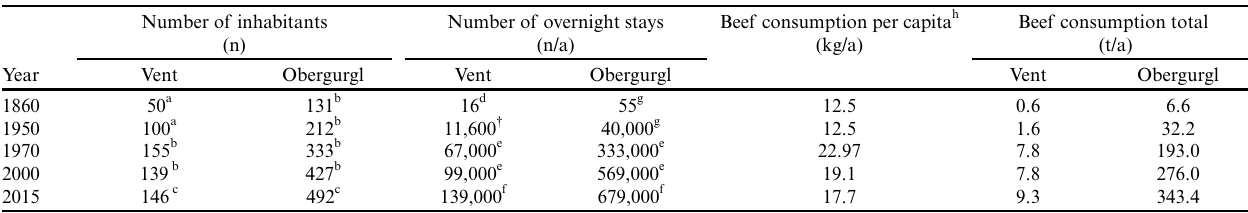
Table 5 . Beef demand in the villages Vent and Obergurgl for the five historical time steps. Number of inhabitants (n)